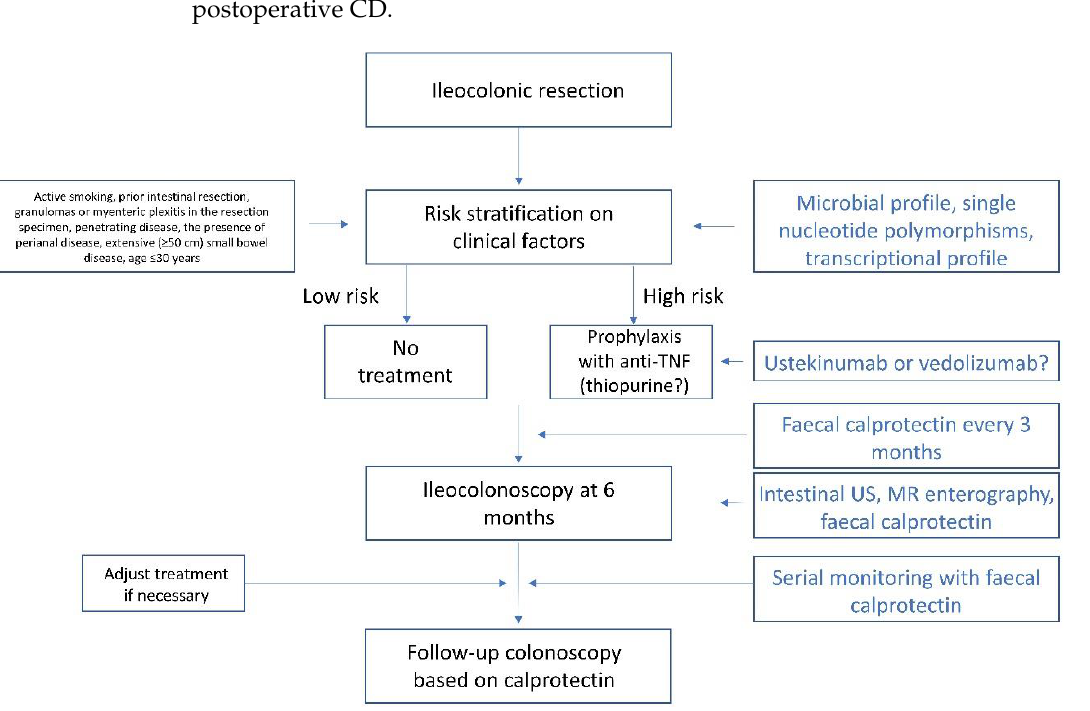
Figure 2. Proposed management algorithm for Crohn’s disease after ileocolonic resection, based on current guidelines (American Gastroenterological Association, British Society for Gastroenterology, European Crohn’s and Colitis Organization). Text in blue denotes potential changes to the algo- rithm in the near future. Abbreviations: MR—magnetic resonance; TNF—tumor necrosis factor;